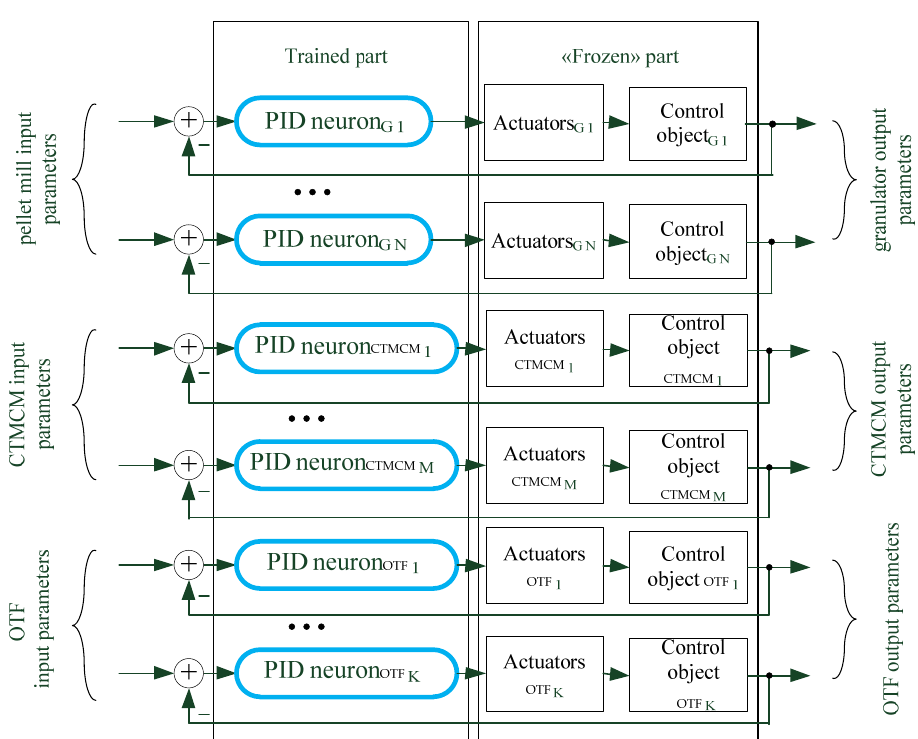
Figure 3. Control channel architecture with an artificial PID neuron. The collection of PID neurons of individual control channels for the whole CETS represents an artificial neural network. Its architecture is shown in Figure 4.